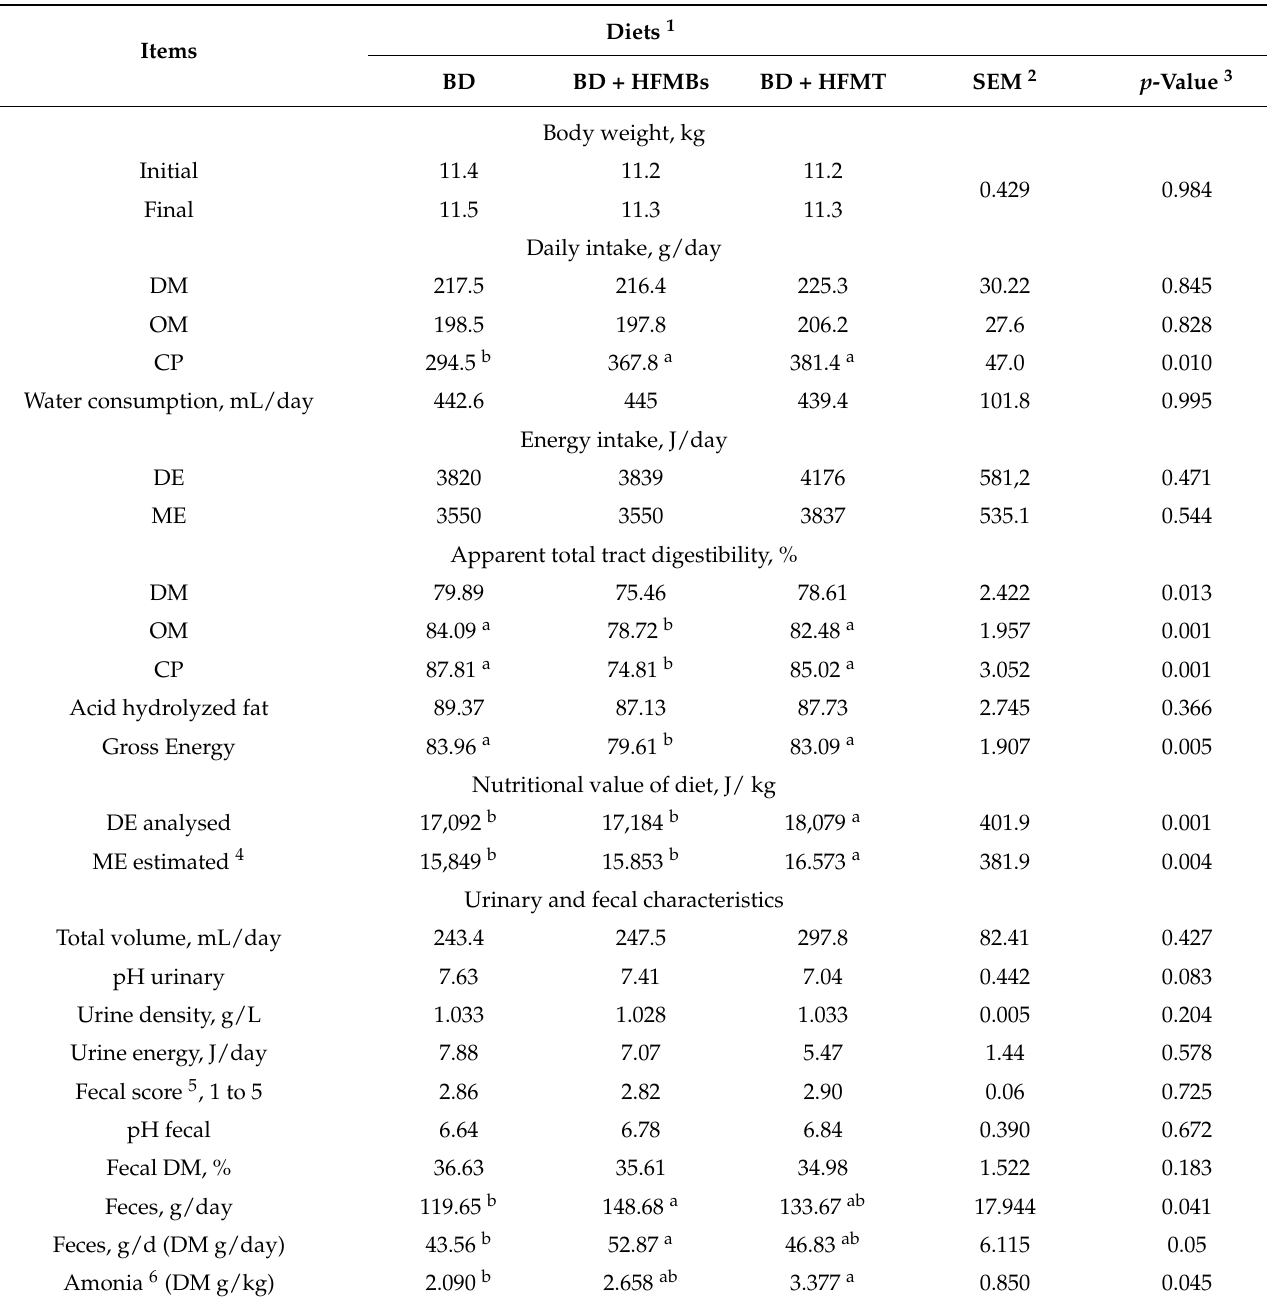
Table 3. Nutrient intake, apparent total tract digestibility, fecal and urinary characteristics of dogs fed diets